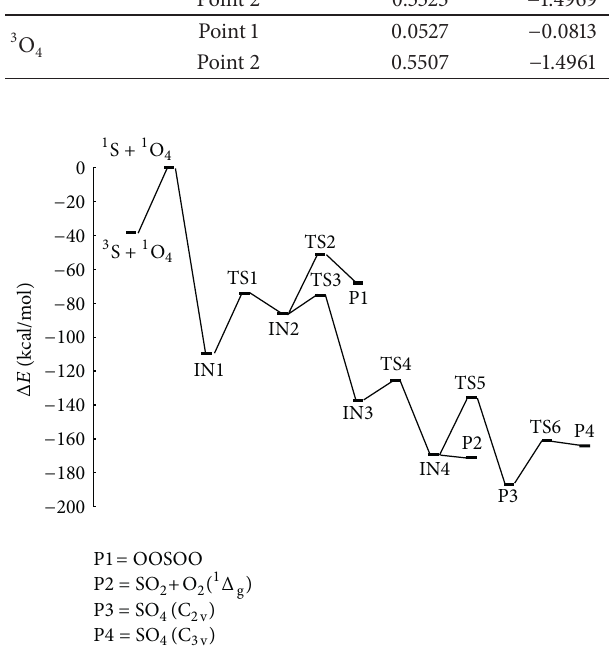
Figure 2: Profile of calculated potential energy surface of 1 S+ 1 O reaction at B3LYP level of computation.